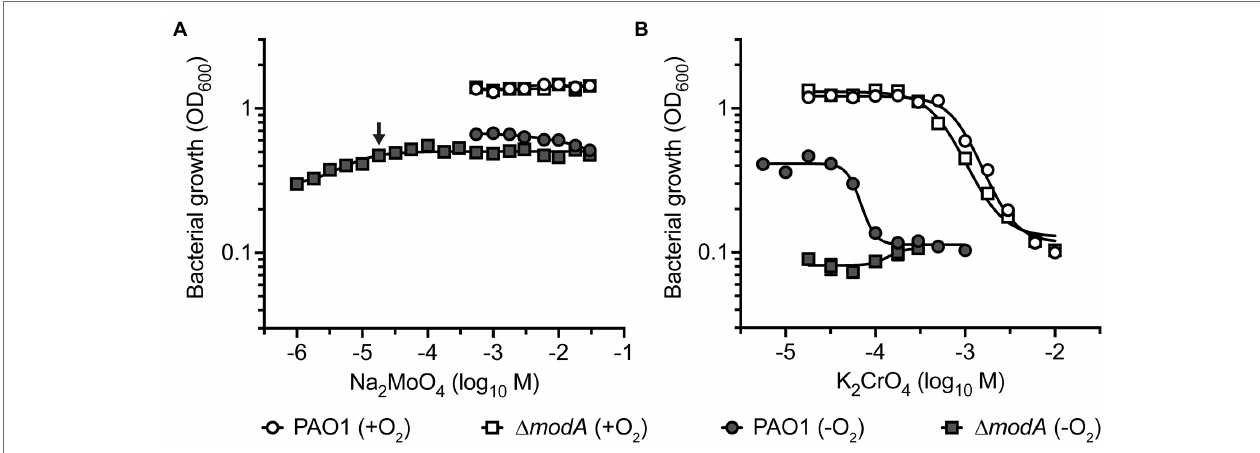
FIGURE 5 | The impact of molybdate and chromate exposure on cell growth. Growth analysis of P. aeruginosa PAO1 wild-type and ∆ modA strains after 24 h of aerobic (+O 2 ) and anaerobic ( − O 2 ) growth in CDM media supplemented with increasing concentrations of (A) Na 2 MoO 4 and (B) K 2 CrO 4 . One hundred millimolar KNO 3 was added to CDM for anaerobic growth. Data corresponds to mean log 10 OD 600 values ± SEM ( n = 3). The concentration of Na 2 MoO 4 required to restore optimal growth of the ∆ modA strain in anaerobic conditions is indicated by an arrow. Where error bars are not visible, they are overlapped by